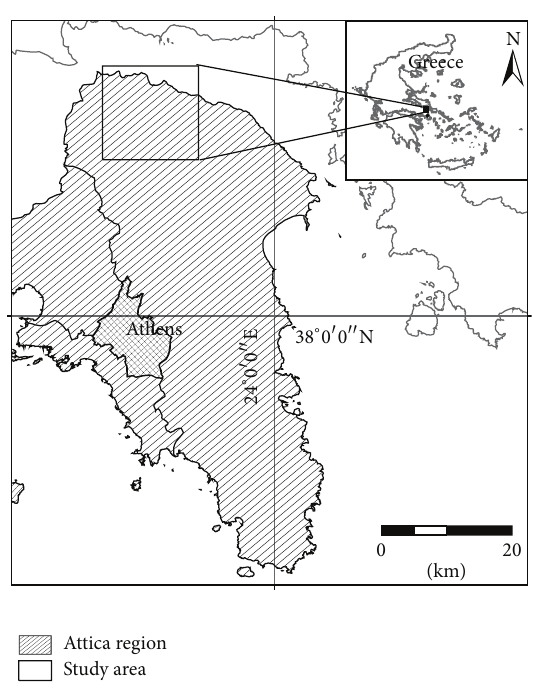
Figure 1: Location map of the area